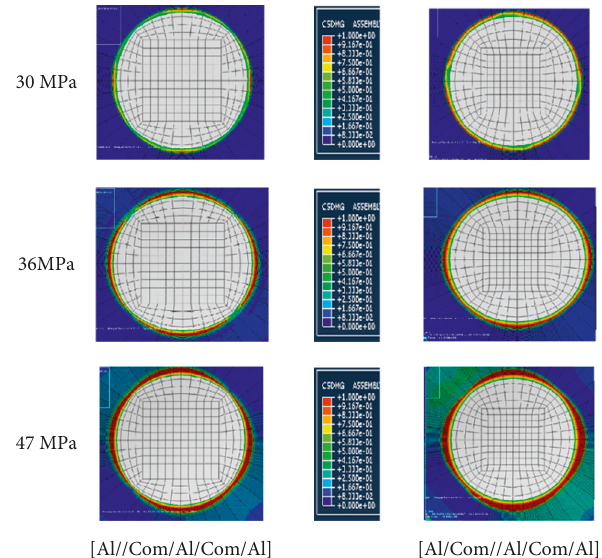
Figure 13: Contour plots of delamination growth of GLARE 3-3/2-0.4 in different shear load